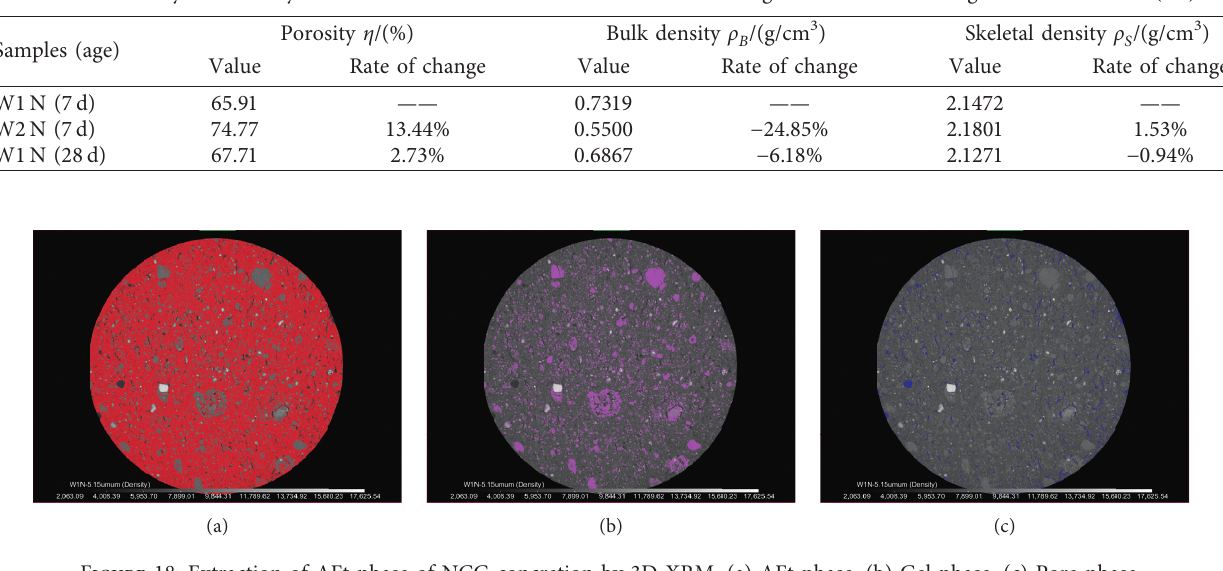
Figure 18: Extraction of AFt-phase of NCG concretion by 3D-XRM. (a) AFt-phase. (b) Gel-phase. (c) Pore-phase.